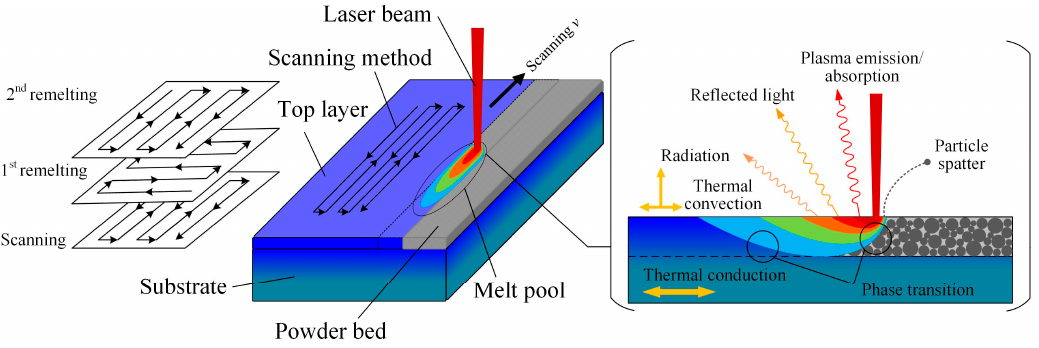
Figure 1. Heat dissipation process in selective laser melting (SLM).